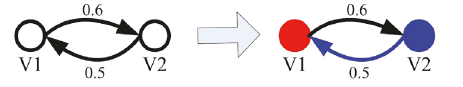
Figure 3: A simple example of circular